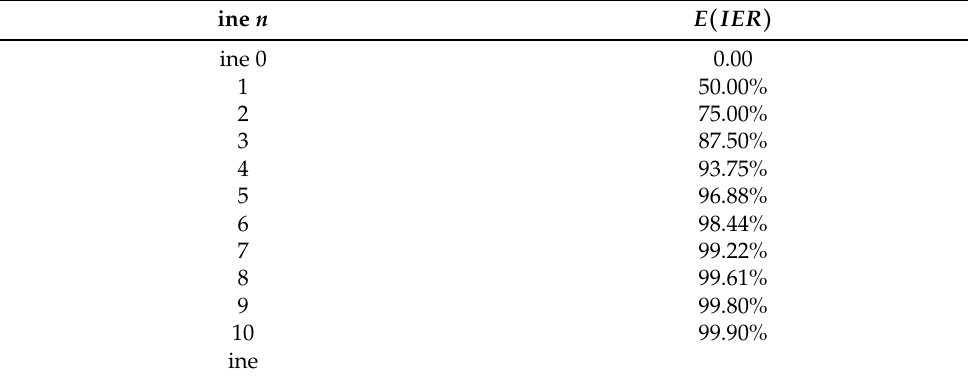
Table 4. The mathematical expectation of the